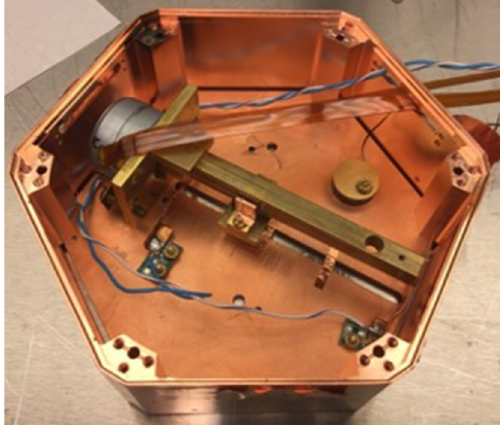
Fig. 3 Shown is the orientation of the Am-241 source mover before it was